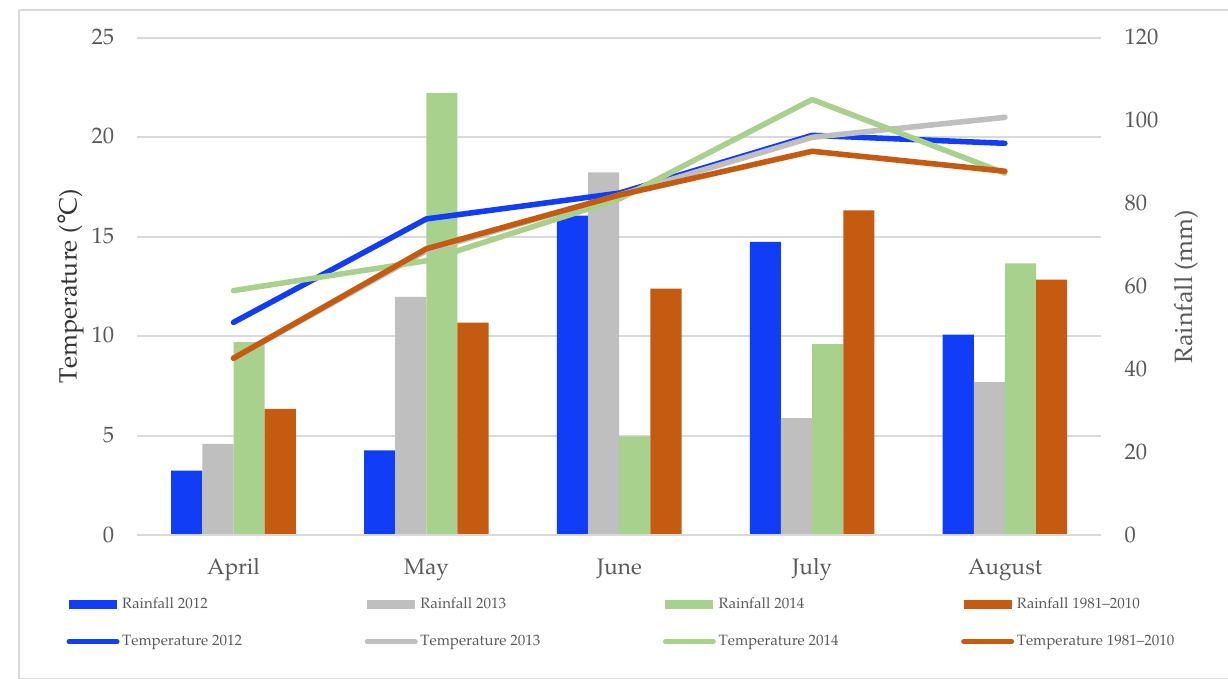
Figure 1. Average month temperature and rainfall amount within sweet maize growing vegetation in the years 2012–2014. The average air temperature in all years of the study was higher than the multiannual average. The most favorable thermal conditions for maize growth, especially at the beginning of the growing season, occurred in 2012. In April (10.7 °C) and May (15.9 °C), the average air temperatures were higher than the multiannual average by 2.5 and 2.4 °C, respectively. Thermal conditions in 2012 influenced the average length of the growing season and contributed to earlier reaching harvest maturity by 7 days than in 2013 and by 10 days than in 2014.